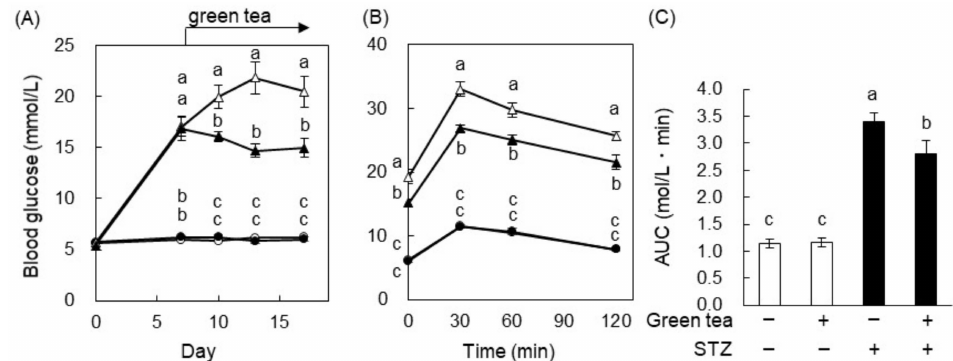
Figure 2. Green tea ameliorated hyperglycemia and glucose intolerance in STZ-induced type I diabetes mellitus(T1DM)rats. TheratsweretreatedasdescribedinFigure1A.( A )Theirbloodglucoseconcentrations were measured 0, 7, 10, 13, and 17 days after the STZ injection. ( B ) An oral glucose tolerance test (OGTT) was performed on Day 17. The rats were orally administered glucose (2 g / kg body weight) after 18 h